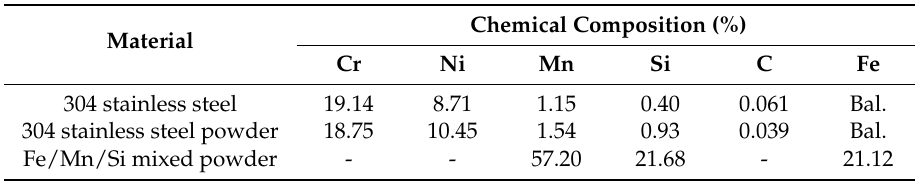
Table 1. Chemical compositions of 304 stainless steel, 304 stainless steel powder and Fe/Mn/Si mixed powder (wt.